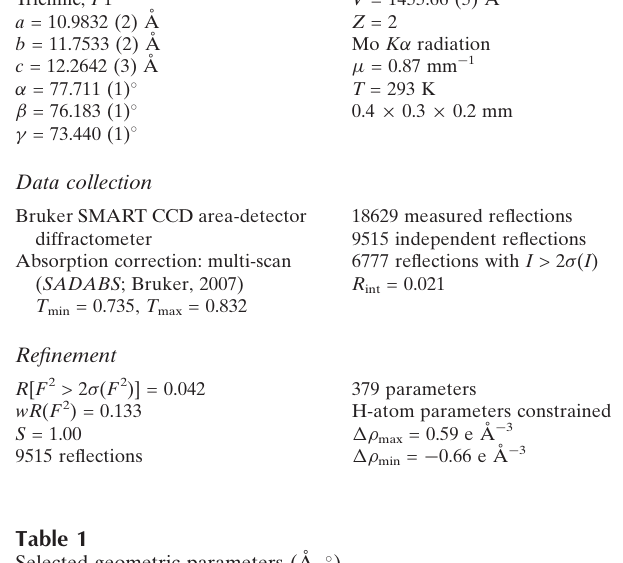
Selected geometric parameters (A˚ , (cid:3) ).